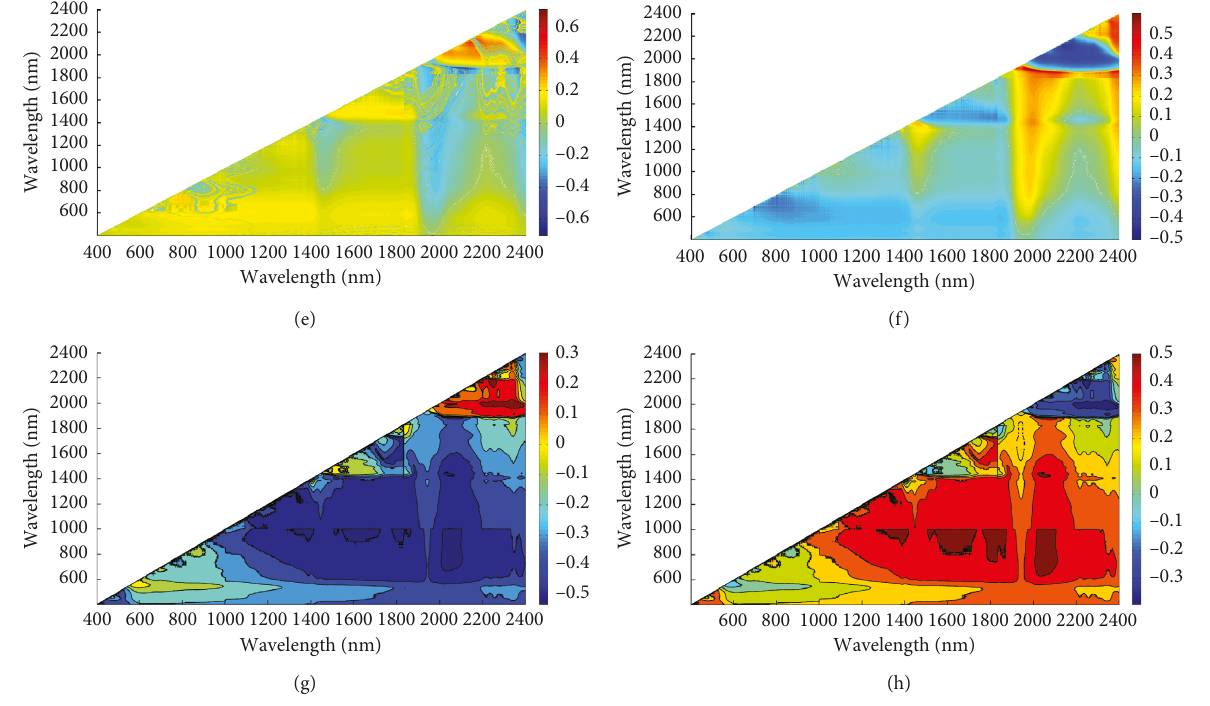
Figure 3: Two-dimensional maps of the correlation between optimized spectral indices and SSC. (a) NDSIs (Ebinur Lake Basin). (b) RSIs (Ebinur Lake Basin). (c) NDSIs (Ugan-Kuqa Oasis). (d) RSIs (Ugan-Kuqa Oasis). (e) NDSIs (Keriya Oasis). (f) RSIs (Keriya Oasis). (g) NDSIs (All data). (h) RSIs (All